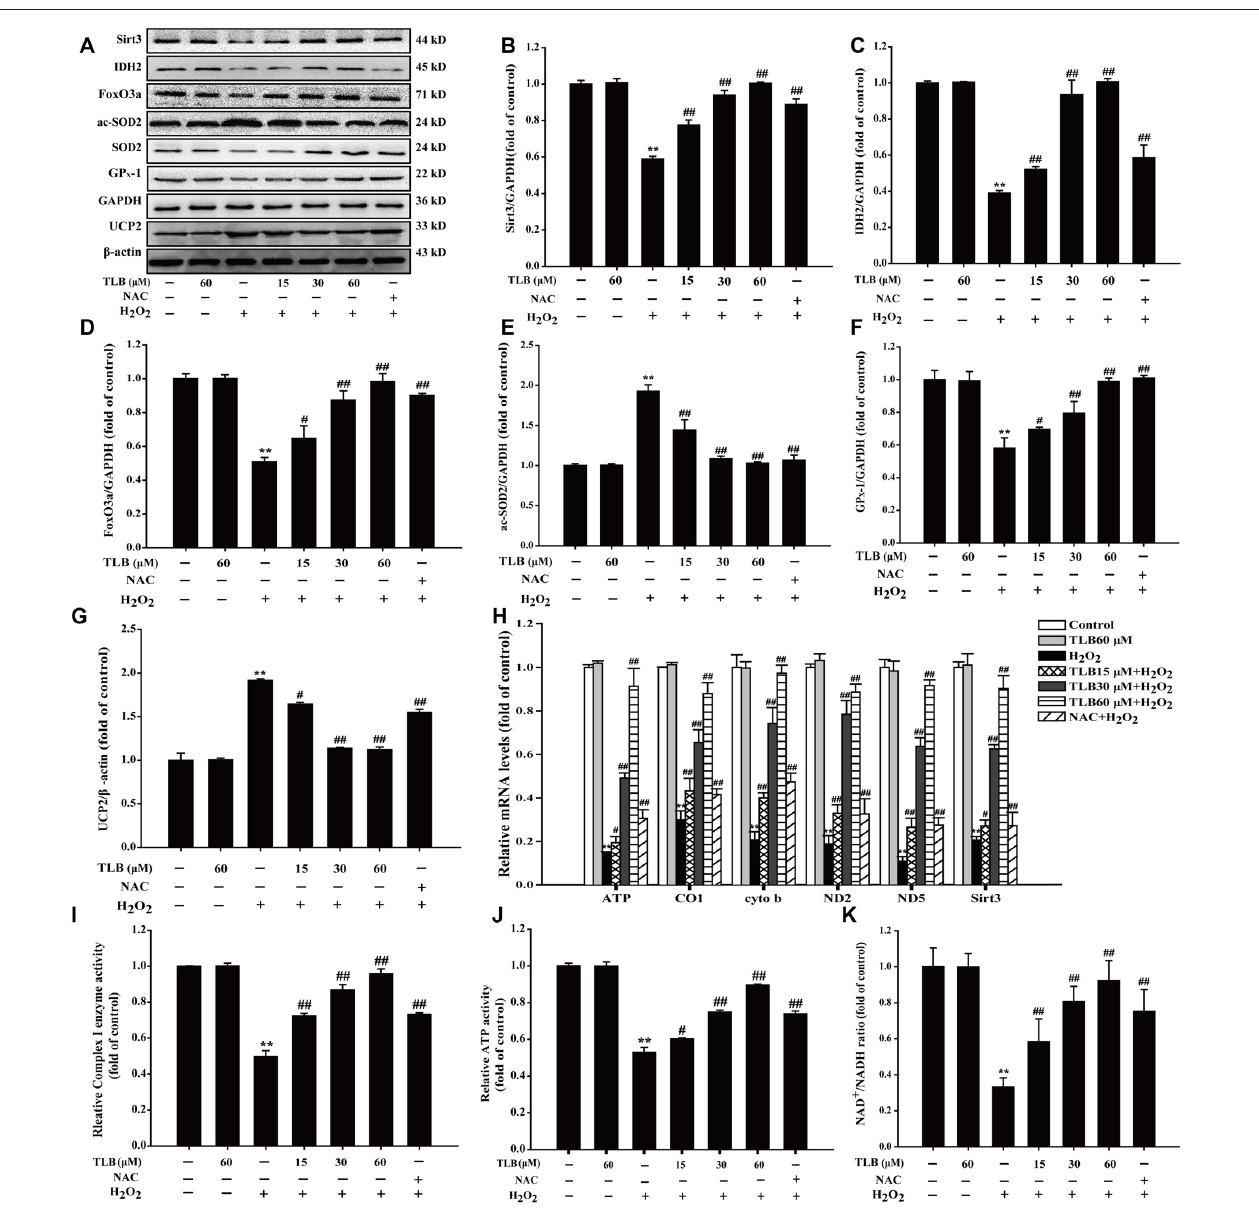
FIGURE 4 | Mitochondrial respiratory chain and silent mating-type information regulation 2 homolog 3 (Sirt3) pathway mediated the protective effects of TLB in PC12 cells. Following pre-treatment with or without TLB for 1 h and incubated with 400 µ M H 2 O 2 for further 48 h, and the mitochondria in each group were isolated and purified. (A) Representative Western blots were shown for Sirt3, IDH2, forkheadboxO3a (FoxO3a)-, ac-SOD2, GP X -1 and uncoupling protein 2 (UCP2) proteins. (B) Quantitation of Sirt3 protein. (C) Quantitation of IDH2 protein. (D) Quantitation of Foxo3a protein. (E) Quantitation of ac-SOD2 protein. (F) Quantitation